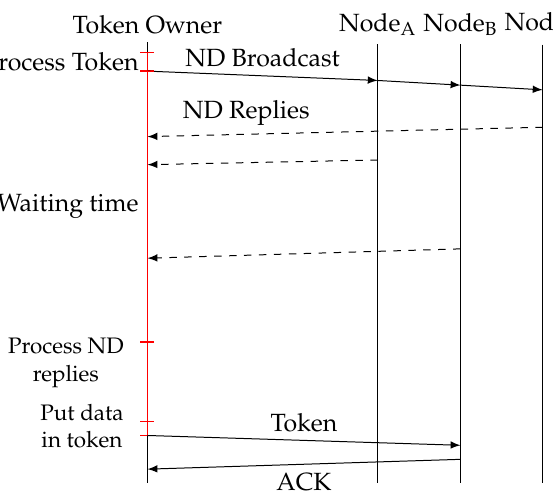
Figure 2. Token passing scheme for Discovering